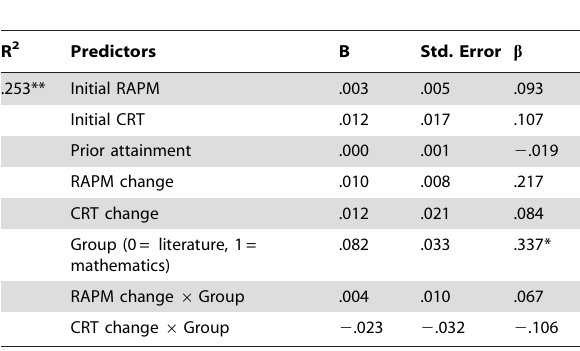
Table 4. A regression analysis, predicting change in defective conditional index